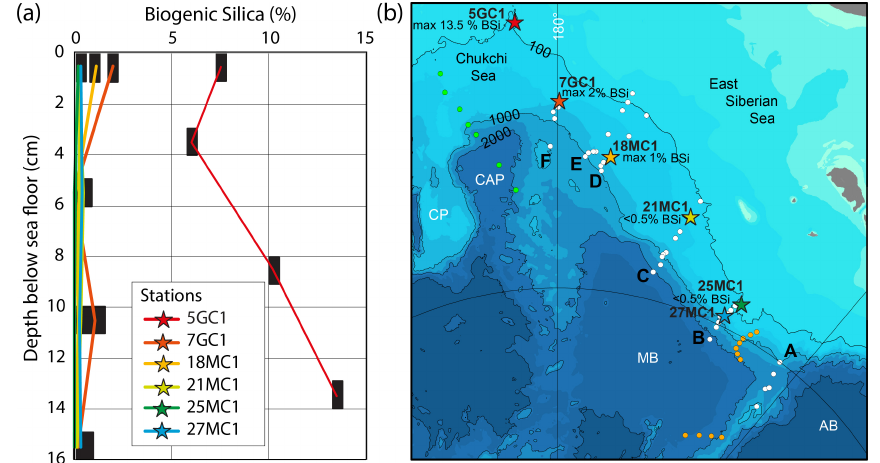
Figure 4. Biogenic silicate (BSi) concentrations (percent dry weight) in the upper 16cm of the sediment (a) at coring sites shown in panel (b) . The symbols of the coring sites are colour coded after measured BSi concentration from the lowest concentrations in blue to the highest in red. The black bars represent the depth layer of the sediment that is